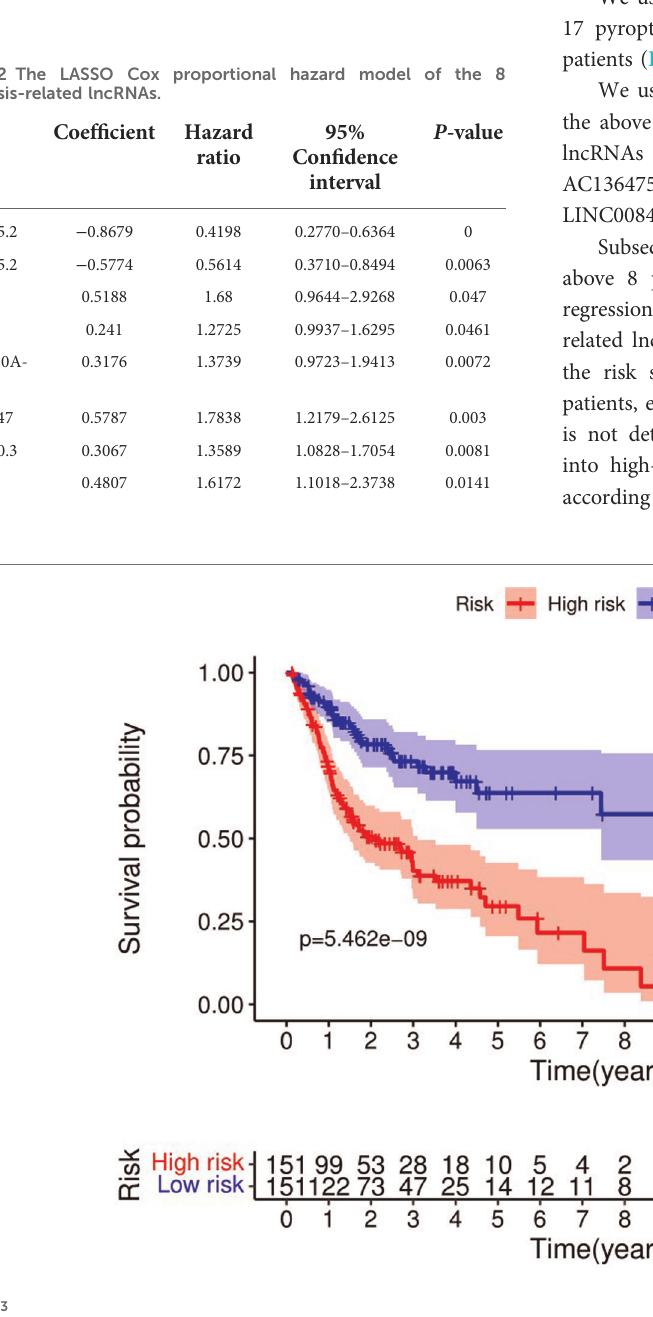
FIGURE 3 Kaplan-Meier curve showed that the overall survival of the high-risk group was signi fi cantly lower than that of the low-risk